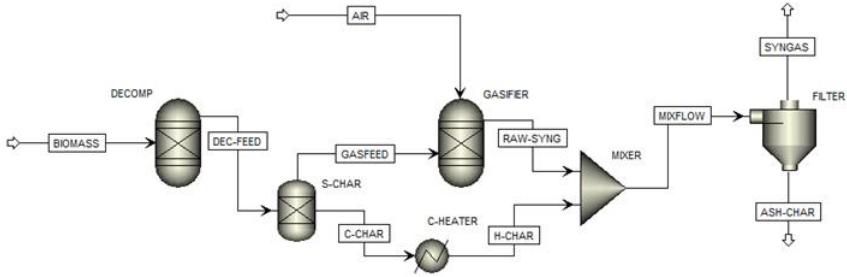
Figure 1. Gasification system flowchart of the proposed model in Aspen Plus.